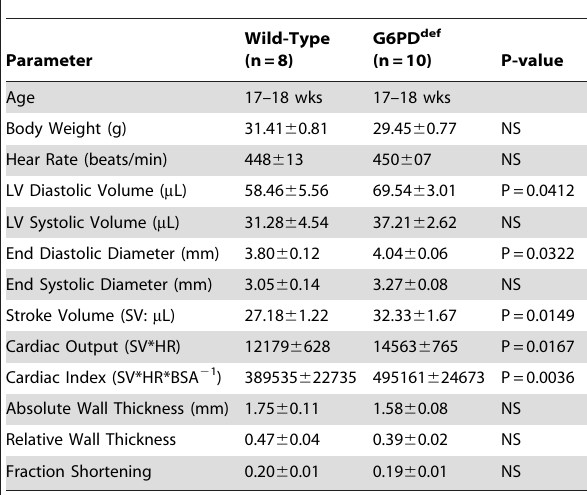
Table 4. Summary data of M-mode